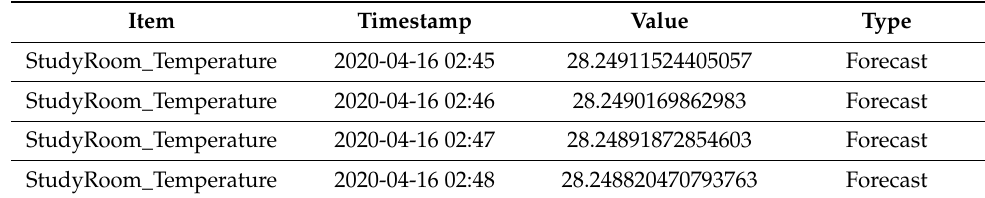
Table 4. Sample forecasting results using